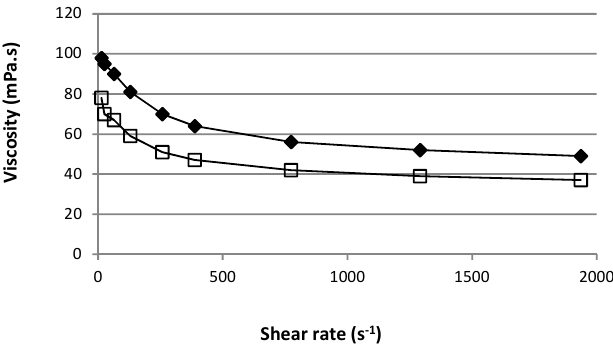
Figure 6. Rheological profiles of the two optimized mixed gels based on HPβCD ( ) or HPγCD ( ). Figure 4. Plots of 1/ k vs. [HPβCD] ( ) or [HPγCD] ( ) (assuming 1:1 stoichiometry) for dexamethasone acetate at a column temperature equal to 40 °C. Stationary phase: phenyl silica gel; mobile phase: mixture methanol: water (70:30 v / v ). Table 4. Apparent association constants K of the complexes DXMa/HPβCD and DXMa/HPγCD determined by chromatographic procedure at various temperatures compared to literature data.